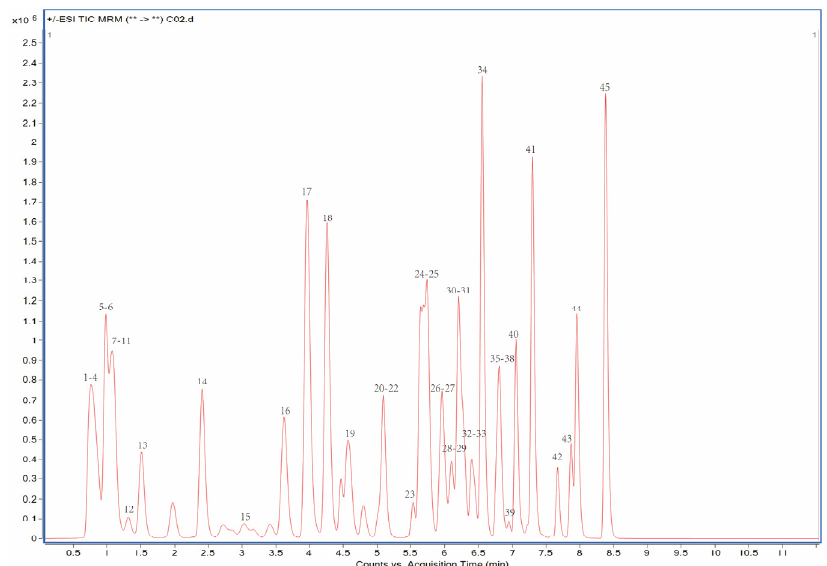
Figure 3. Ultra-performance liquid chromatography multiple reaction mode (UPLC-MRM) chro- matogram of 10 µ g/L of 45 pesticide standards.